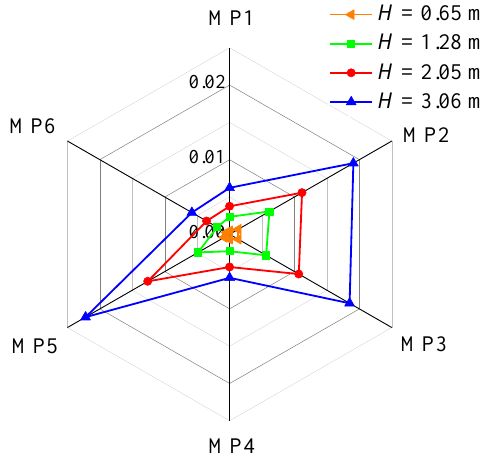
Figure 7. The C p value of f 1 among MP1–6 at α = +2° with different runaway heads.